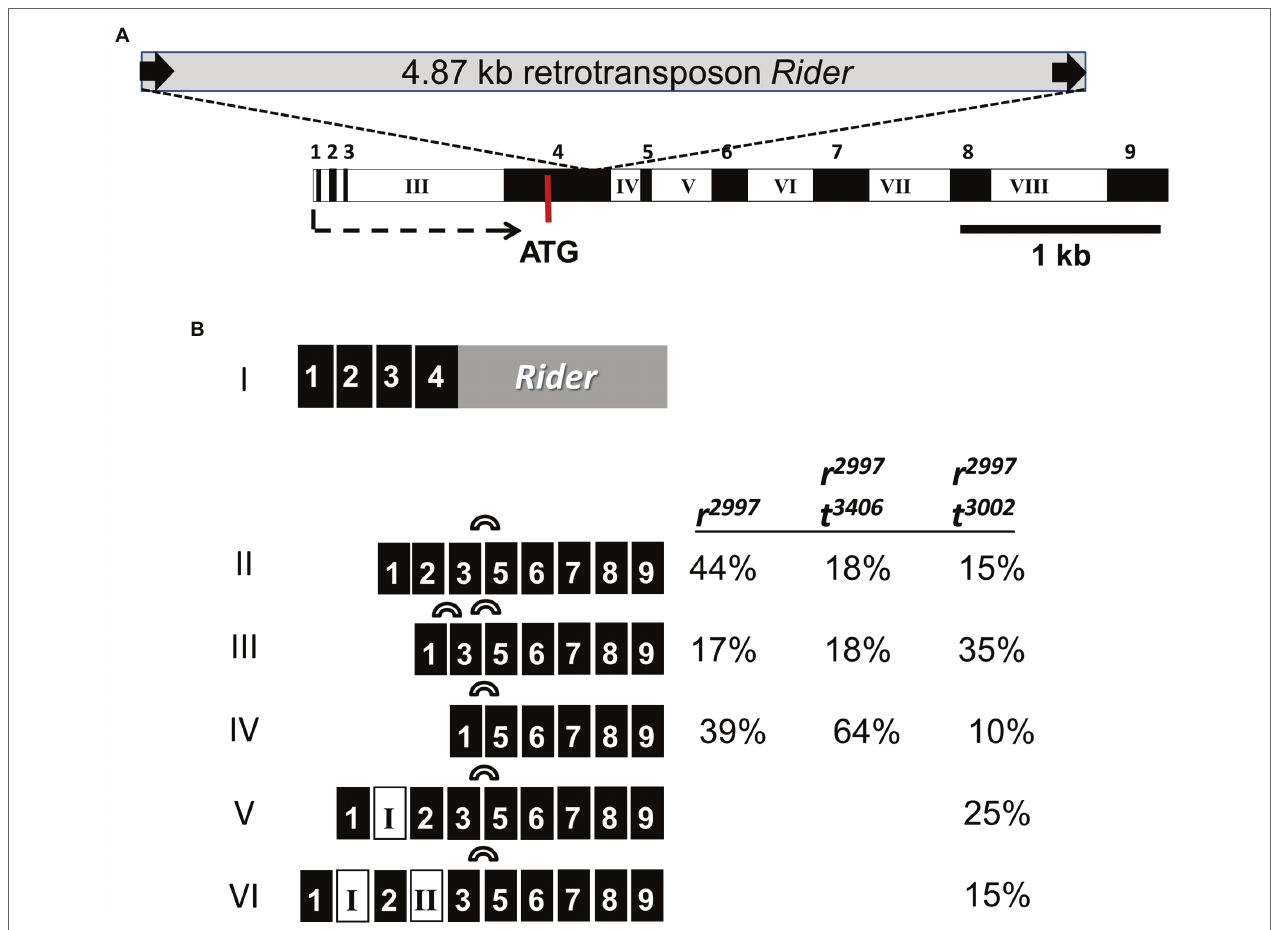
FIGURE 2 | The PSY1 gene in the mutant r 2997 and its transcripts. (A) Genomic structure of PSY1 with nine exons (filled boxes) and eight introns. The Rider retrotransposon is located in exon #4. Arrow indicates transcription initiation. (B) PSY1 transcript variants detected in fruits of mutant r 2997 and double mutants r 2997 / tangerine . The proportions of the various transcripts were calculated from the total transcripts that contained exons 5–9.